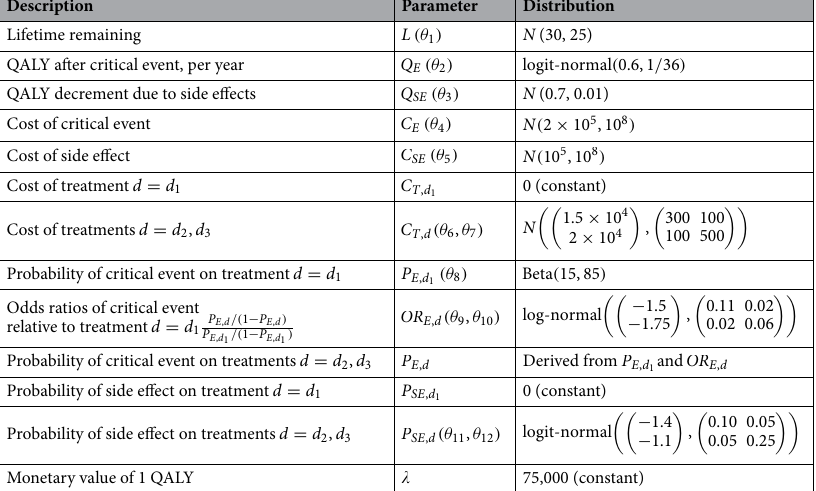
Table 1. The input parameters involved in the synthetic testcase. Note that log-normal (µ , �) and logit-normal (µ , �) denote the log-normal and logit-normal distributions, respectively, with µ and (cid:31) being the mean vector and the covariance matrix of the corresponding normal distribution, respectively. Beta (α , β) denotes the Beta distribution with shape parameters α , β > 0 . The word QALY appearing in the first column stands for quality-adjusted life